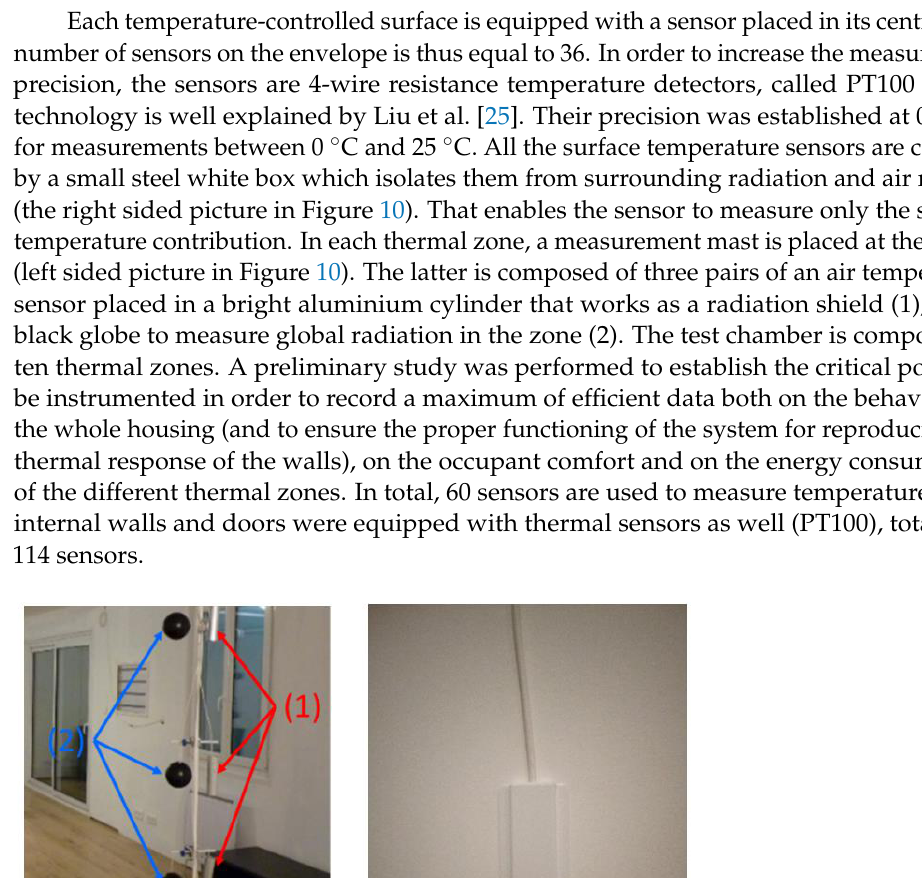
Figure 11. ( a ) a mobile measurement mast. ( b ) a psychrometric data logger. In a nutshell, nearly 300 sensors were installed in the test chamber in order to record the regulation parameters of the envelope, the thermal comfort of the occupants, the indoor air quality, and the energy consumption. 2.5. Dynamical Control of the Experimental Facility The cold chamber, the TAPs, and the measurement setup are put together in order to reproduce the dynamical thermal behaviour of the building. An experiment campaign works as follows. Before starting experimentation in the test chamber, a weather file and the envelope composition are selected. The thermal properties of the selected materials are then injected into Equations (3) – (6). At initial conditions, we would like to start with an air temperature of say, 20 °C in the test chamber. Therefore, the temperature of the envelope is calculated using a steady state equation in which data from the first line of the weather file and a theoretical indoor air temperature equal to 20 °C are used. All TAPs are